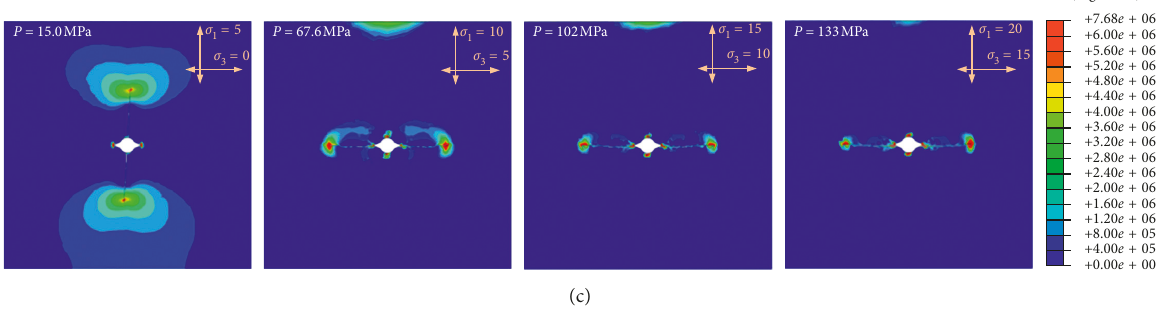
Figure 15: The crack characteristics under the conditions of σ θ 90 ° . (cid:31)